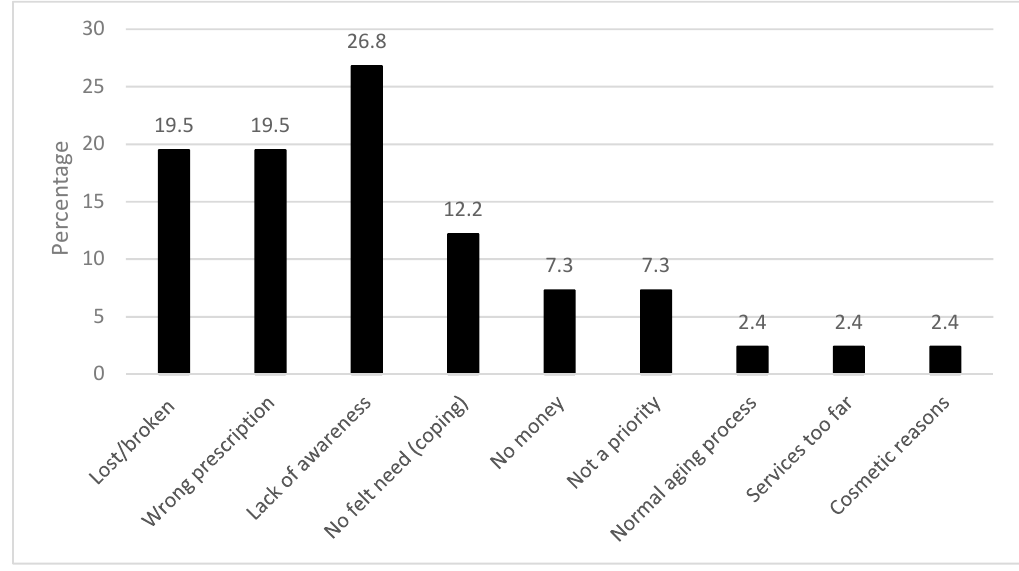
Figure 3. Barriers to presbyopic correction coverage.